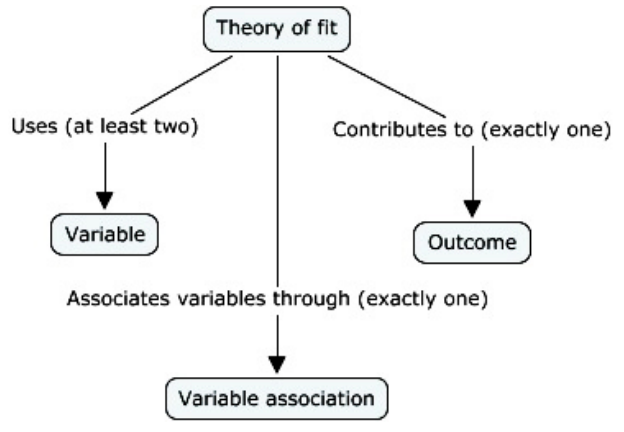
Fig. 3 . Basic design pattern for expressing theories of fit in Web Ontology